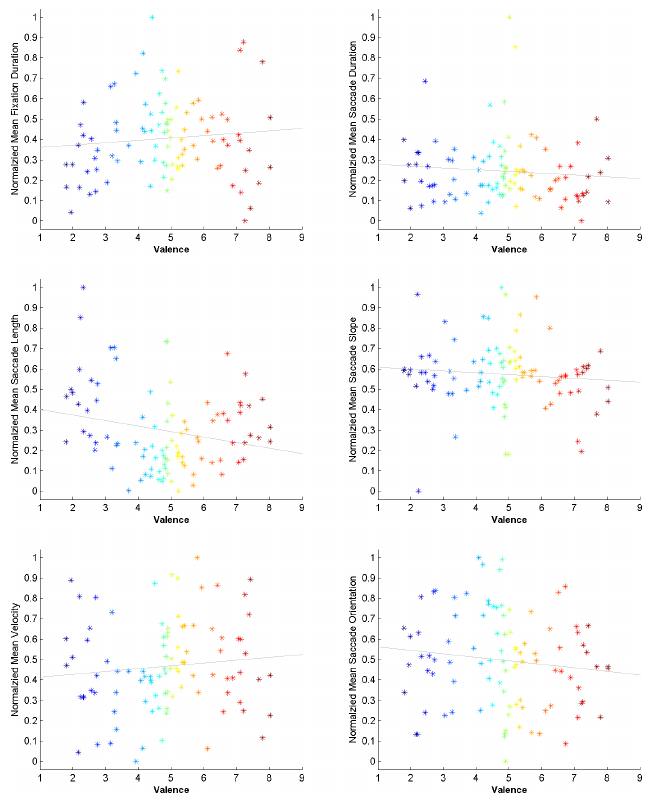
Fig 4. Mean value features versus valence. From left to right: mean fixation duration (m = 0.012, p = 1.32e- 36), mean saccade duration (m = -0.008, p = 1.11e-26), mean saccade length (m = -0.027, p = 1.77e-25), mean saccade slope (m = -0.002, p = 1.49e-35), mean saccade velocity(m = 0.004, p = 0.14), mean saccade orientation (m = -0.017, p = 5.19e-37).